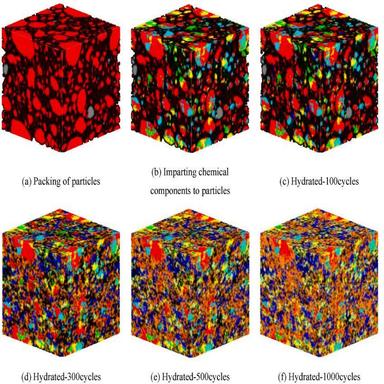
Hydration process of cement paste obtained by CEMHYDED